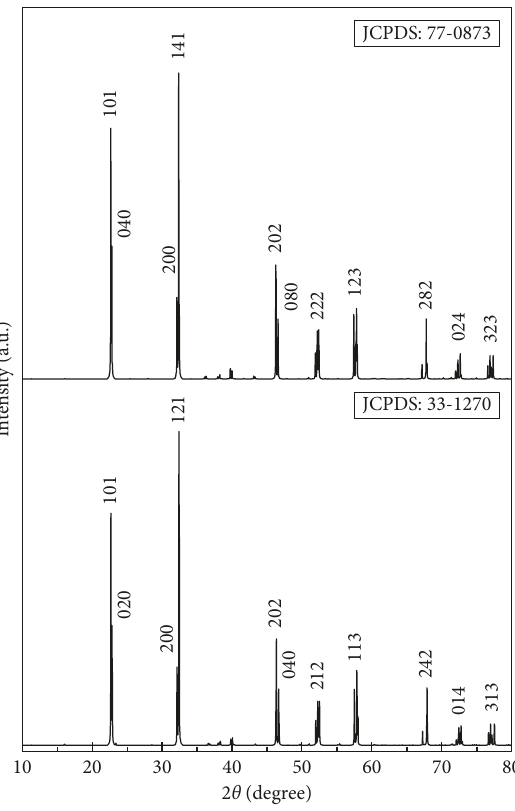
Figure 3: Diffraction patterns simulated orthorhombic NaNbO with spatial group Pbma (JCPDS: 33-1270) and P2 1 ma (JCPDS: 77- 0873). Figure